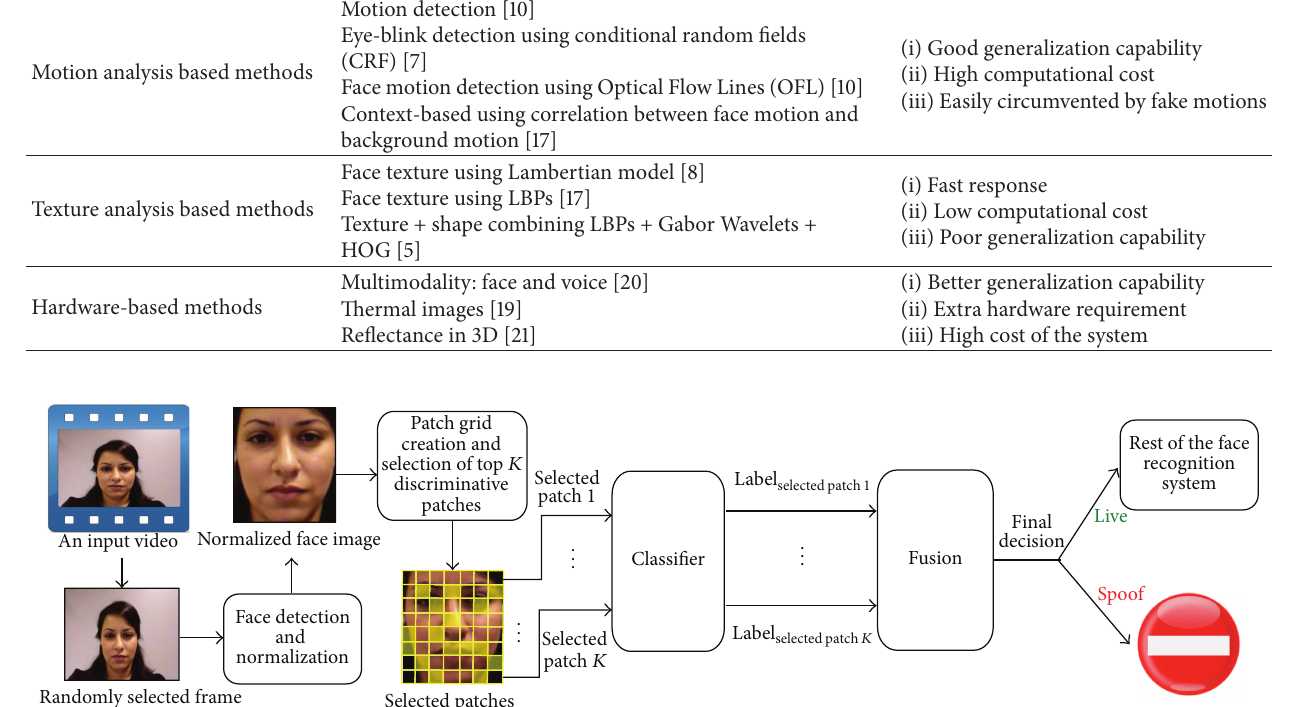
Figure 3: The proposed face spoof recognition algorithm based on discriminative image